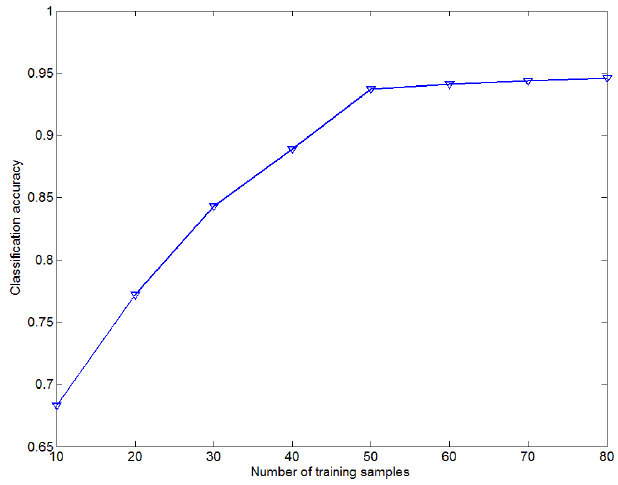
Figure 23. Overall accuracies using different number of training samples in UC_MERCED dataset.